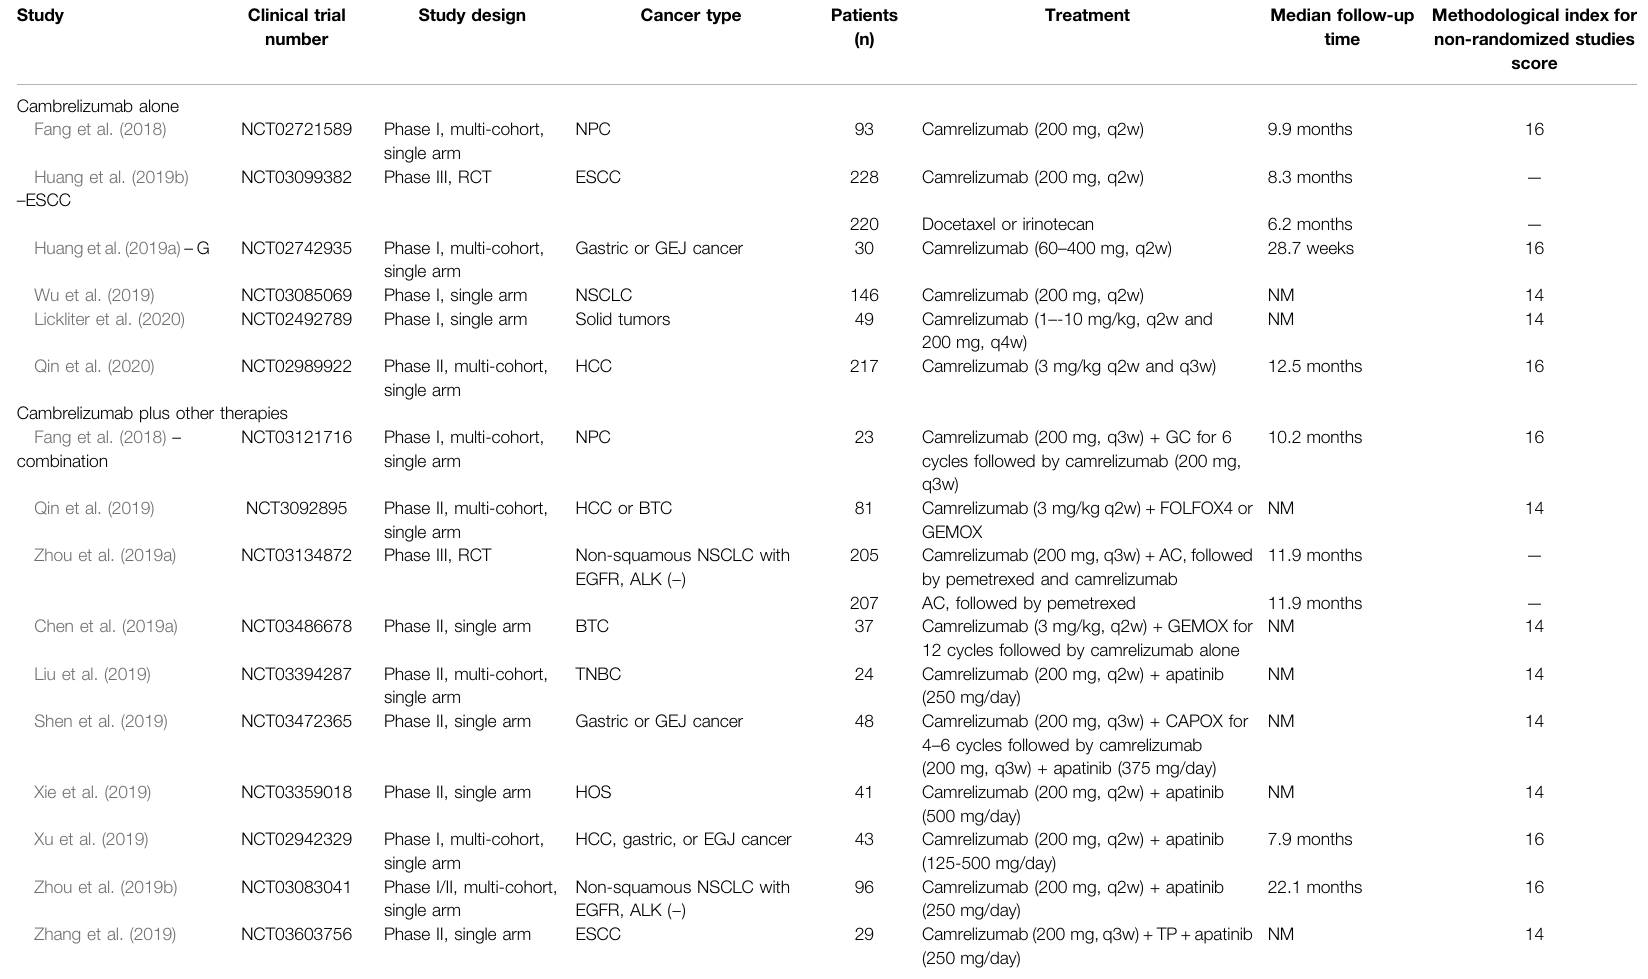
TABLE 1 | Basic information of included